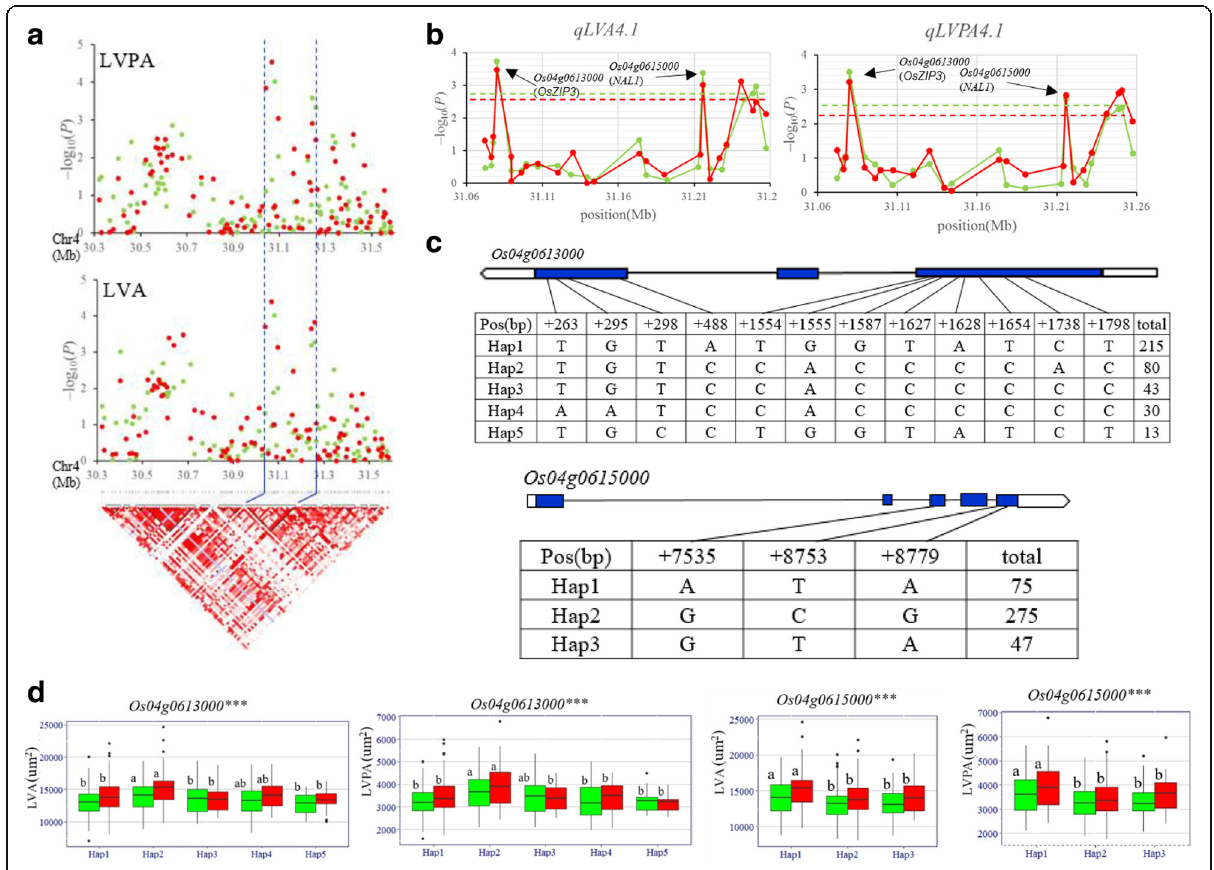
Fig. 4 Gene-based association analysis and haplotype analysis of targeted genes related to qLVA4.1 and qLVPA4.1 . a Local Manhattan plot (top) and LD block (bottom) surrounding the peak on chromosome 4. Dashed lines indicate the candidate region for the peak. b Gene-based association analysis of targeted genes related to qLVA4.1 and qLVPA4.1 . Each point is a gene indicated by one SNP having largest – log10 ( P ) value. Dash line show the threshold to determine significant SNP. c Exon-intron structure of Os04g0613000 and Os04g0615000, and DNA polymorphism in those gene. d Boxplots for LVA and LVPA based on the haplotypes (Hap)for Os04g0613000 and Os04g0615000 . The *** suggest significance of ANOVA at P <0.001. The letter on histogram (a, and b) indicate multiple comparisons result at the significant level 0.05. Green and red colors indicate in 2015 and 2016,